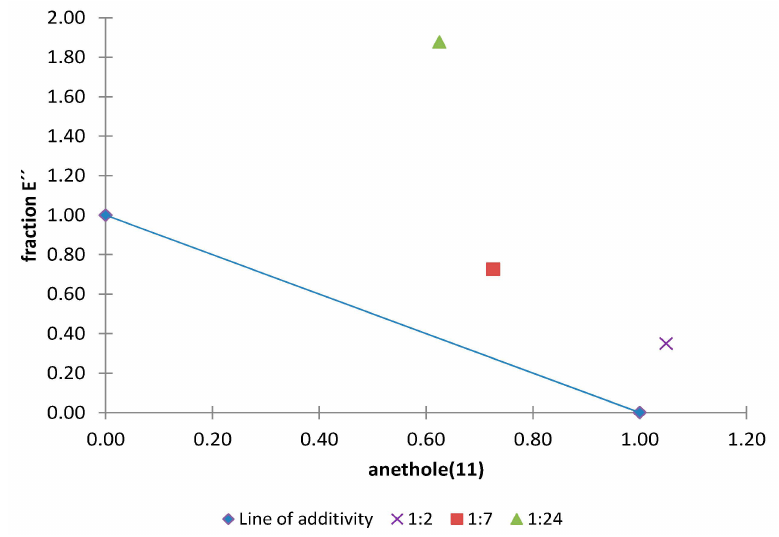
Figure 16. Normalized isobologram (ED 50 ) for the complex mixture anethole ( 11 )/fraction E 11 (from the acetone extract) in the etiolated wheat coleoptile bioassay. (Combination ratios 1:2; 1:7; 1:24). The 1:2 and 1:7 ratios did not show significant differences on applying Student’s t test, thus indicating an additive effect. The 1:24 ratio is located above the line of additivity and a significant difference was observed on applying Student’s t test, thus indicating an antagonistic